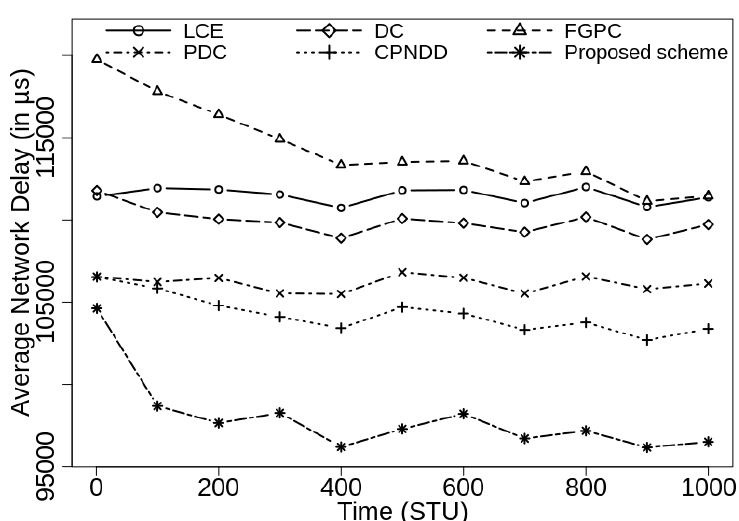
Figure 9. Comparison of average network delay (in µ s) with λ = 50/s, | CS ( R i ) | = 100, α = 0.7, and | Ctlg | =